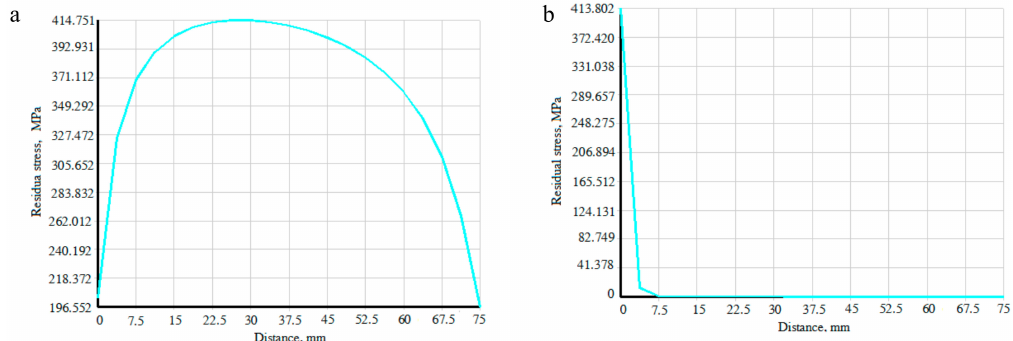
Figure 9. Distribution of residual stress inside the laser welding model in the directions ( a ) parallel and ( b ) perpendicular to the welding seam.